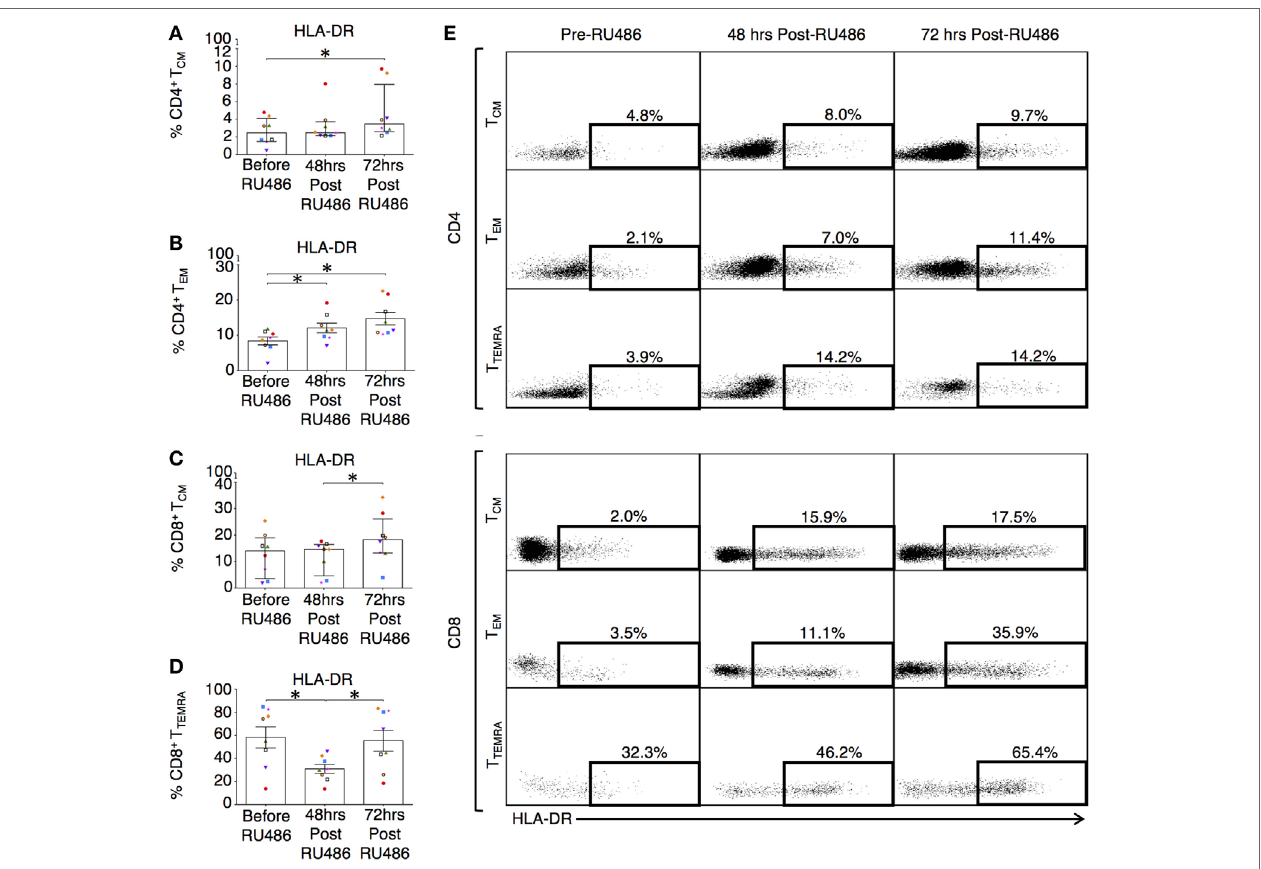
FigUre 10 | Differentiated effector memory subtypes in RU486 treated have an increased expression of HLA-DR. (a) Longitudinal change in percentage expression of HLA-DR on: CD4 T CM (Freidman test with Dunn’s post hoc correction), (B) CD4 T EM [one-way analysis of variance (ANOVA) with Tukey’s post hoc correction], (c) CD8 T CM (Freidman test with Dunn’s post hoc correction), and (D) CD8 T TEMRA (one-way ANOVA with Tukey’s post hoc correction). P values are two tailed and significance is defined as * P < 0.05. (e) Representative flow cytometry plots showing the percentage expression of HLA-DR on both CD4 and CD8 (CCR7 + CD45RA − ) T CM , (CCR7 − CD45RA − ) T EM , and (CCR7 − CD45RA + ) T TEMRA subsets in PBMC from subjects receiving RU486 treatment. Memory CD4 + and CD8 + subset HLA-DR expression, gated with SSC on the vertical axis is shown. Populations were gated using isotype controls and percentages of HLA-DR expressing cells is